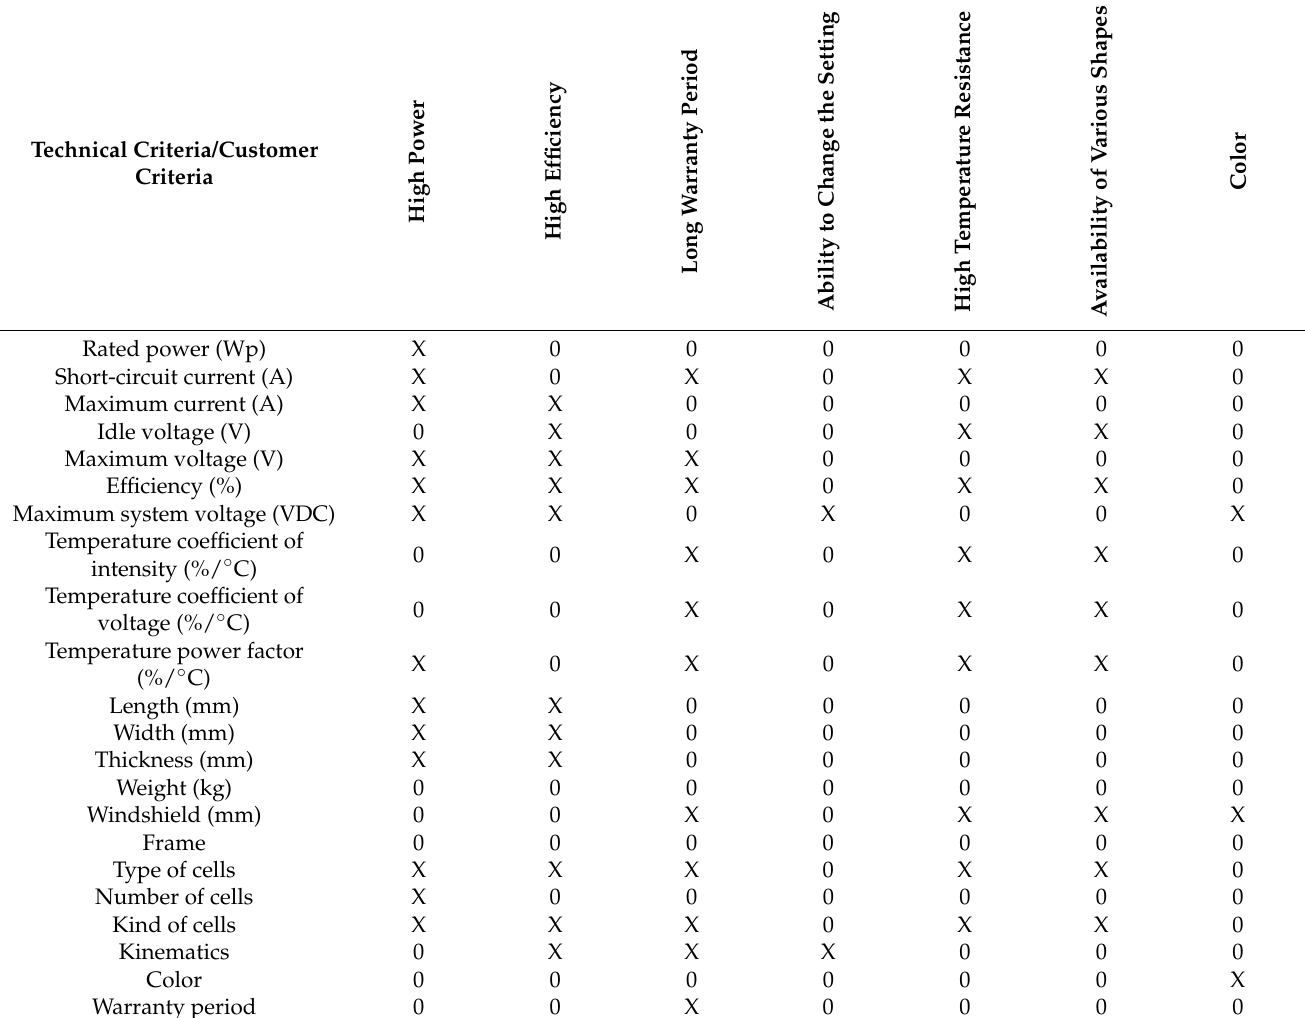
Table 2. Correlation matrix between customer criteria and technical criteria of photovoltaic